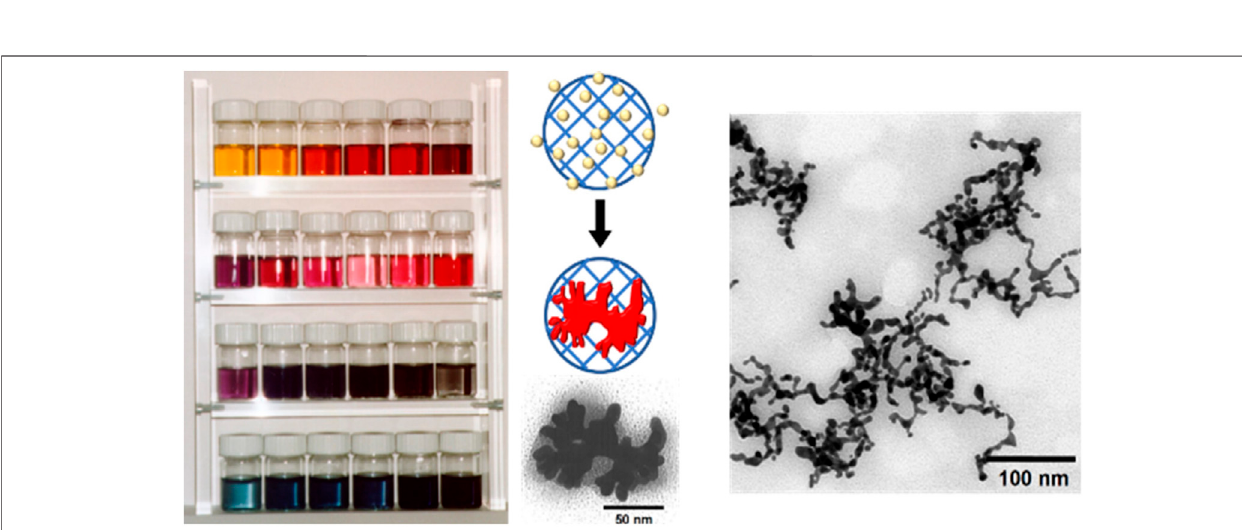
FIGURE 14 | Electrostatic nanotemplating of gold in poly (styrene sulfonate) microgels; left: photograph of gold colloids prepared in microgels templates with varying size and cross-linking density. The different colors of the solutions indicate the adjustable range of gold nanoparticle sizes and morphologies; middle: schematic depiction of gold formation from Au-ions inside the microgel and TEM ofa single gold-particlewith nugget-like morphology with a microgel; right: TEM of threadlike gold within interconnected microgels (Antonietti et al., 1997). Reprinted with permission. Copyright © 1997 by WILEY-VCH Verlag GmbH, Germany.